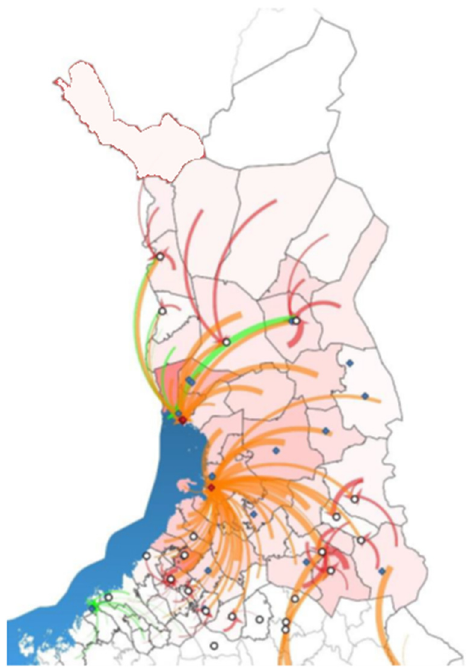
Figure 7. Pulpwood flows of baseline scenario. The thickness of the arrow describes the amount of wood flow. The orange arrow depicts deliveries to factories of the experiment, the red arrow to railway stations, and the green arrow to factories of other companies. The red color scale of the municipalities describes optimized market share.